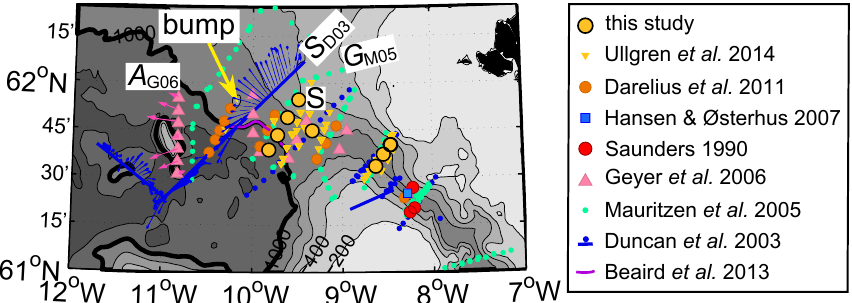
Figure 17. Map showing the positions of the moorings in this study together with the mooring positions of Darelius et al. (2011), Hansen and Østerhus (2007), Saunders (1990), and Geyer et al. (2006). Also shown are CTD station positions from Ullgren et al. (2014) as well as station locations from Mauritzen et al. (2005), and hydrographic sections with CTD/LADCP and deep towed vehicle from Duncan et al. (2003). Shaded bathymetric contours are plotted every 200m; the 1000m contour is bold. Our mooring array S, Geyer’s (2006) mooring array A (A G06 ), Duncan’s section S (S D03 ), and Mauritzen’s section G (G M05 ) are labelled. Current arrows from S D03 and A G06 are shown schematically – not to scale. The topographic bump associated with bifurcation of the flow is marked by a yellow arrow, and a purple line roughly corresponds to the portion of the 1000m isobath where the deeper edge of the plume was found to be deeper than the depth range of Seagliders in Beaird et al. (2013, their Fig.